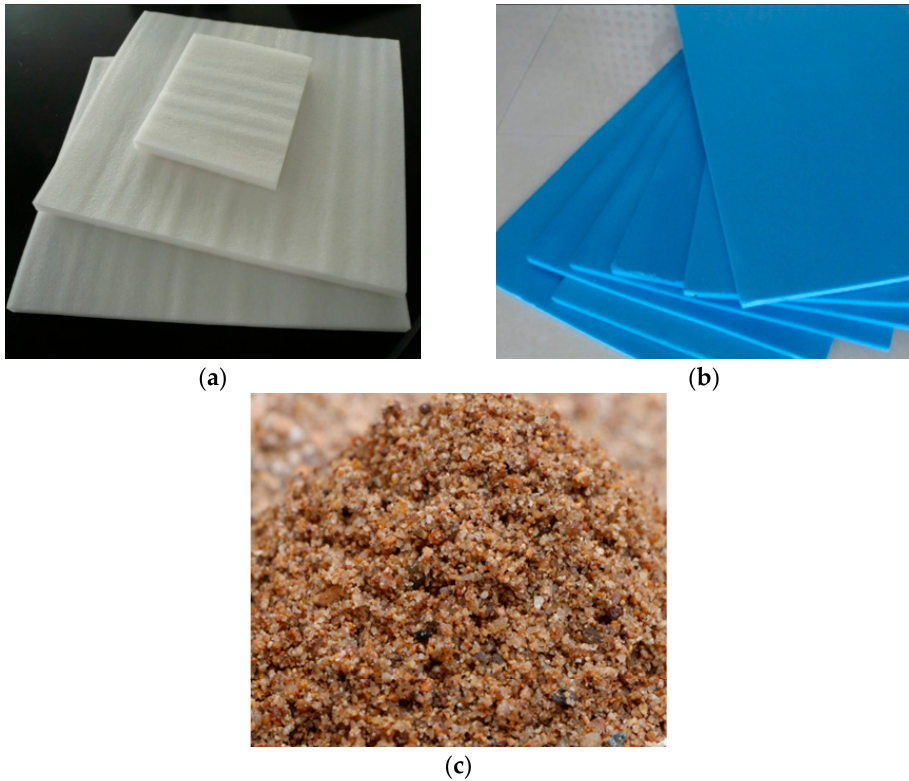
Figure 13. Different cementing joint filling materials: ( a ) EPE; ( b ) XPS; ( c ) sand.